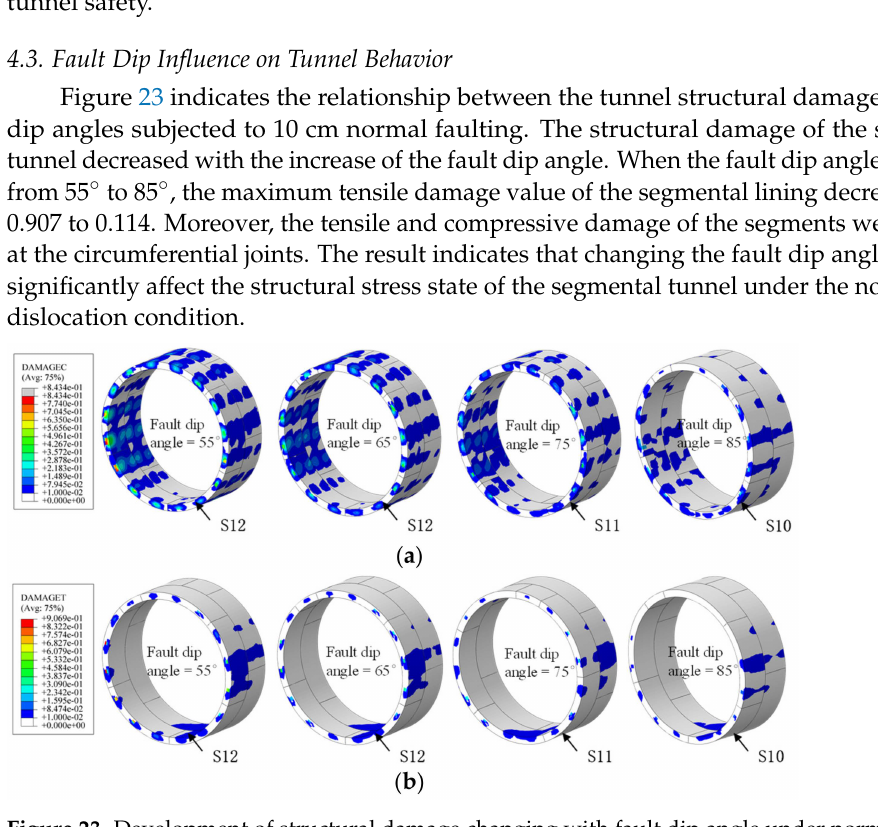
Figure 23. Development of structural damage changing with fault dip angle under normal faulting: ( a ) compression damage of segments and ( b ) tensile damage of segments. Some like +8.434e-01 means 8.434 × 10 − 1